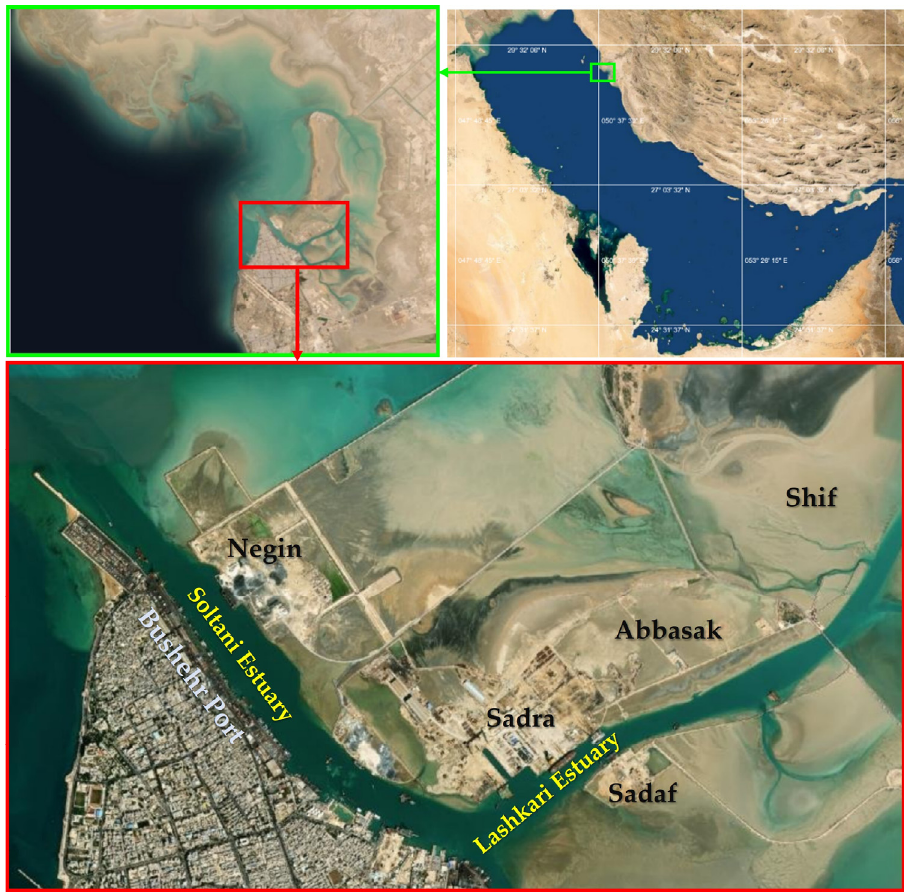
Figure 1. A view of Bushehr Peninsula (top) and the location of Bushehr Port (bottom). The Bushehr Port access channel consists of two segments; the inner and outer channel, which are 3.2 and 9.3 km long, respectively (Figure 2). The inner channel has the same alignment as the Soltani Channel and is connected to the outer channel with a 100° bend. As the channel is located in a very shallow area, continuous deposition of fine sediments leads to deposition rates between 300,000 and 900,000 m 3 /year (10–15 cm/year). A significant volume of annual maintenance dredging is necessary which is very costly for the port; hence, the continuous dredging of approximately 260,000 m 3 /year is carried out in this port. Over the past three decades, the average deposition rate between two capital dredging works is between 500,000 and 700,000 m 3 /year. Meanwhile, after the deepening of the access channel in 2007–2008, the depth of the inner and outer channels has increased to 10.3 and 10.8 m, respectively